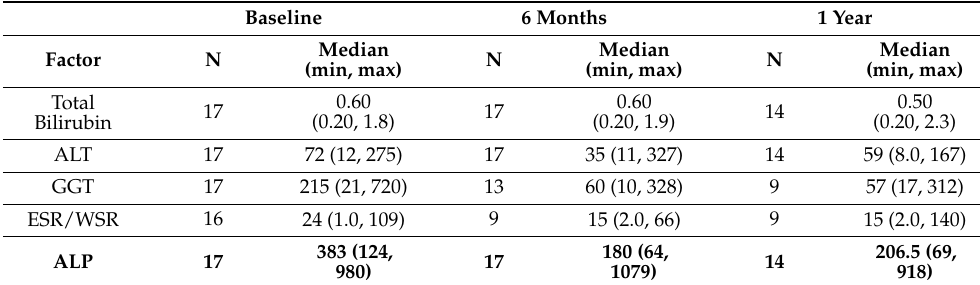
Table 3. Lab parameters for all included patients at baseline, six months and one year of oral vancomycin